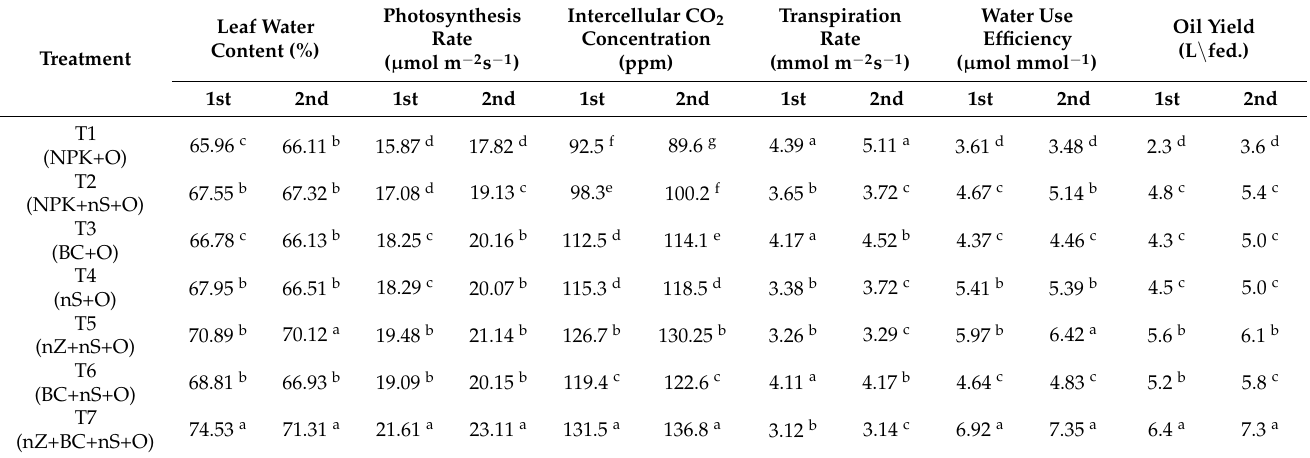
Table 6. Effect of nanoparticles on thyme photosynthetic parameters and oil yield during 2020 and 2021 growing